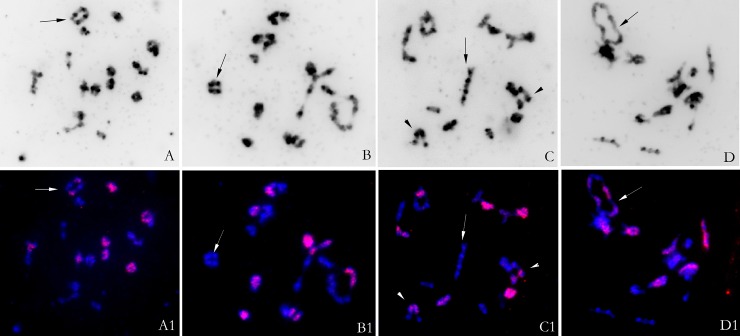
BAC-FISH analysis of meiotic cells from line 21.A–D: Inverted images of DAPI staining. A1–D1: Merged images. Red signals are from the C-genome-specific probe. Arrows show quadrivalents or multivalents. The two arrowheads in C1 show two pairs of homologous chromosomes between A and C genome chromosomes.